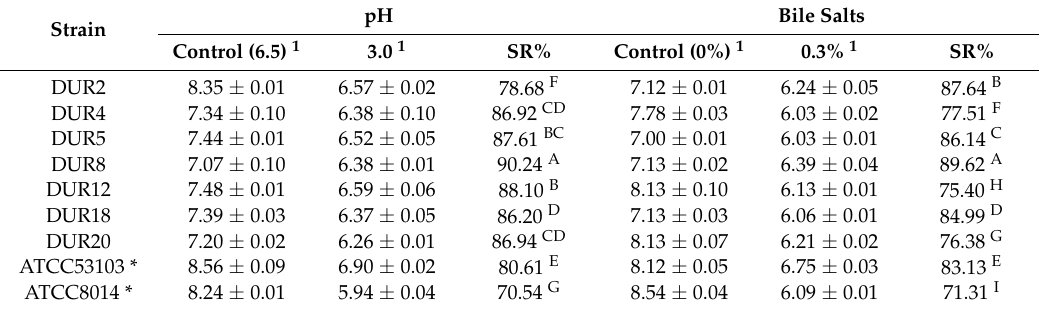
Table 2. Viability of Lactobacillus strains after exposure to pH 3.0 and 0.3% bile salts for 3